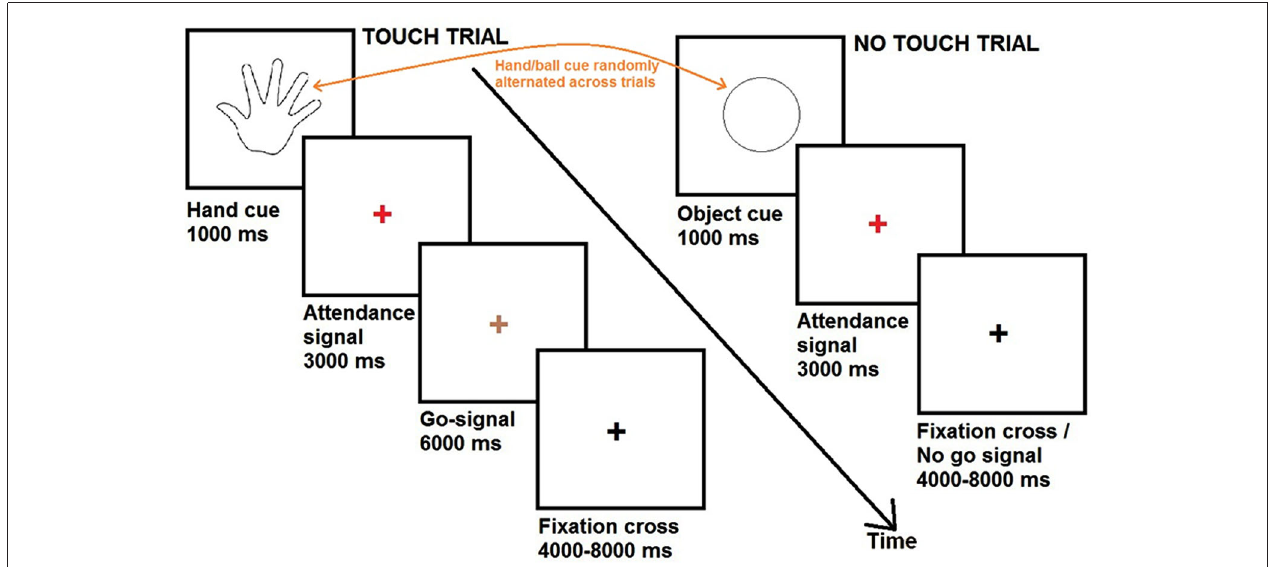
FIGURE 2 | Time course of the